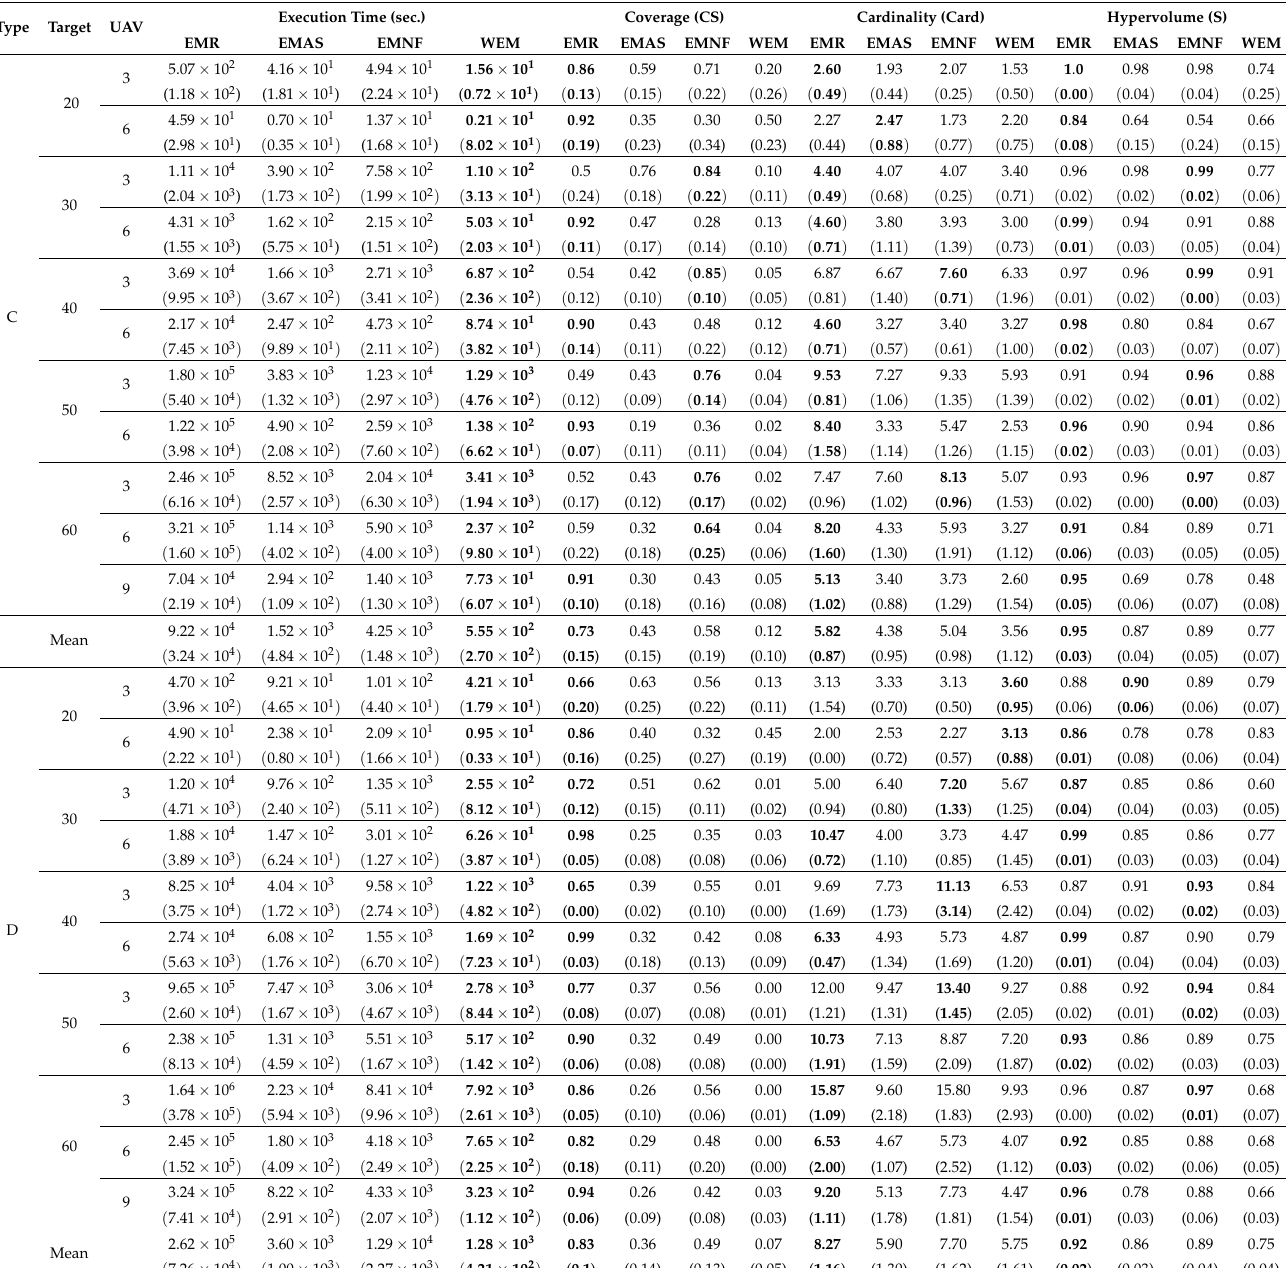
Table 2. Mean values and standard deviations (in the parentheses) for the execution time, coverage, cardinality, and hypervolume